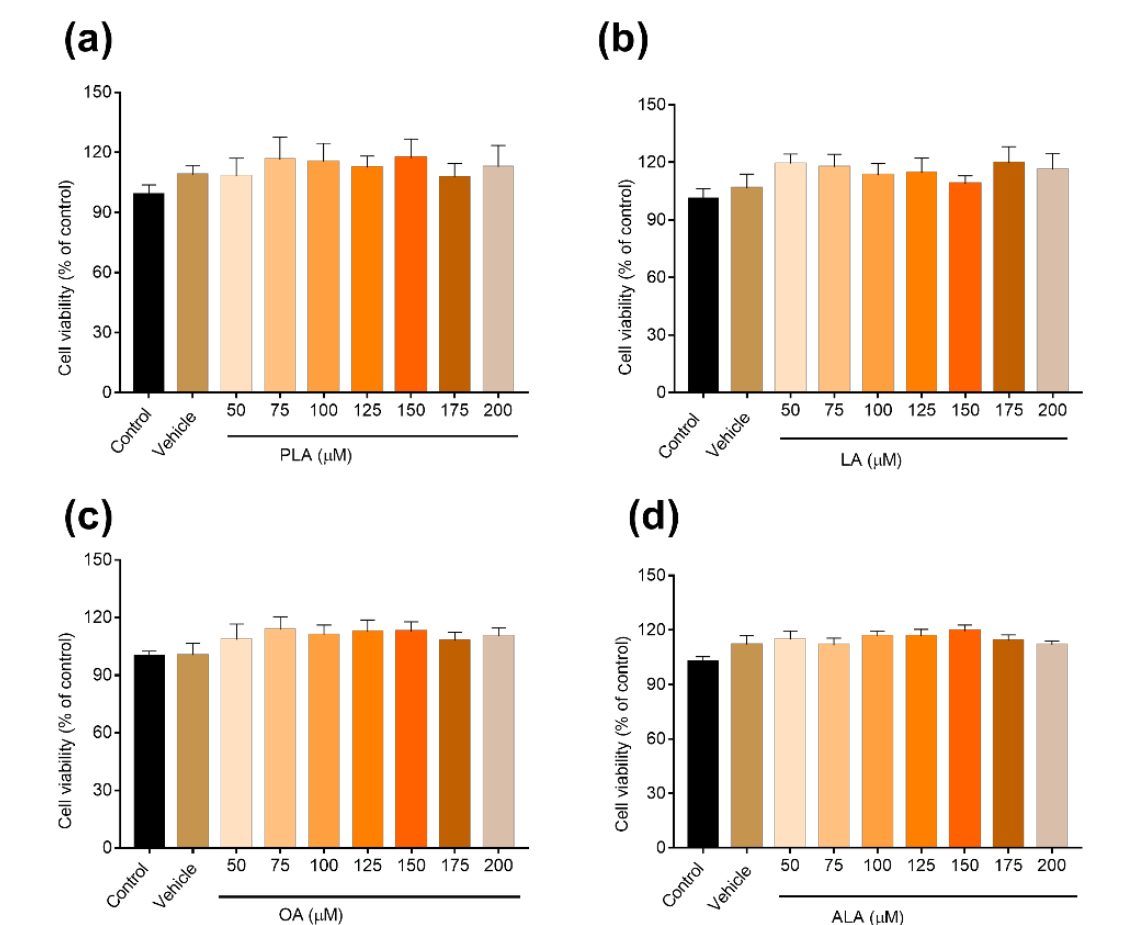
Figure 2. Effects of fatty acids on the cell viability percentage of RAW264.7 cells. ( a ) PLA, ( b ) LA, ( c ) OA, ( d ) ALA.